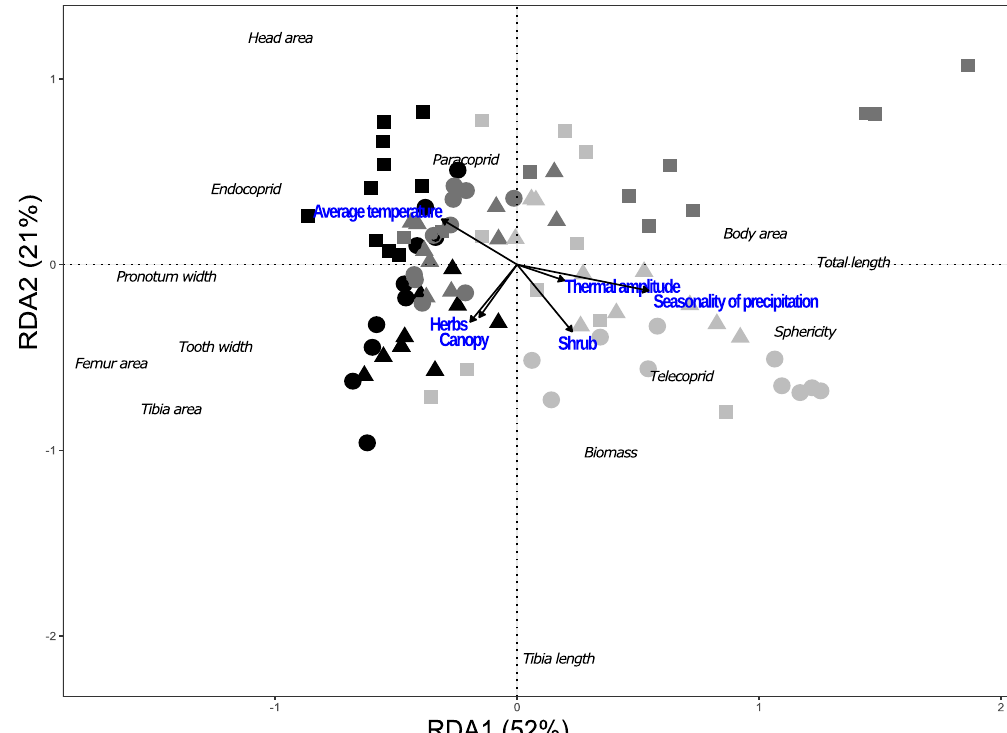
Figure 3. Redundancy analysis based on functional traits of dung beetle assemblages in the native forest and two cattle systems in subtropical forests of Argentina. Black symbols: Atlantic Forest, dark grey symbols: Humid Chaco, light gray symbols: Dry Chaco. Circles: native forest, Triangles: forest with cattle, and Squares: open pasture.